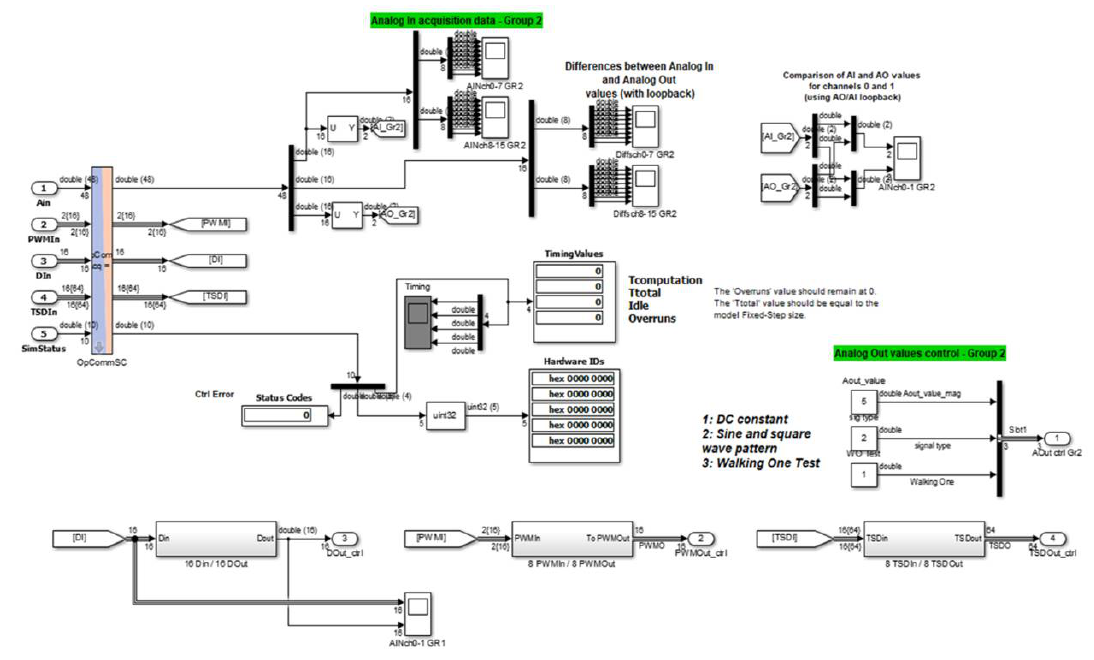
Figure 13. The interfacing between SM-OPAL and the analog IOs of OPAL-RT.